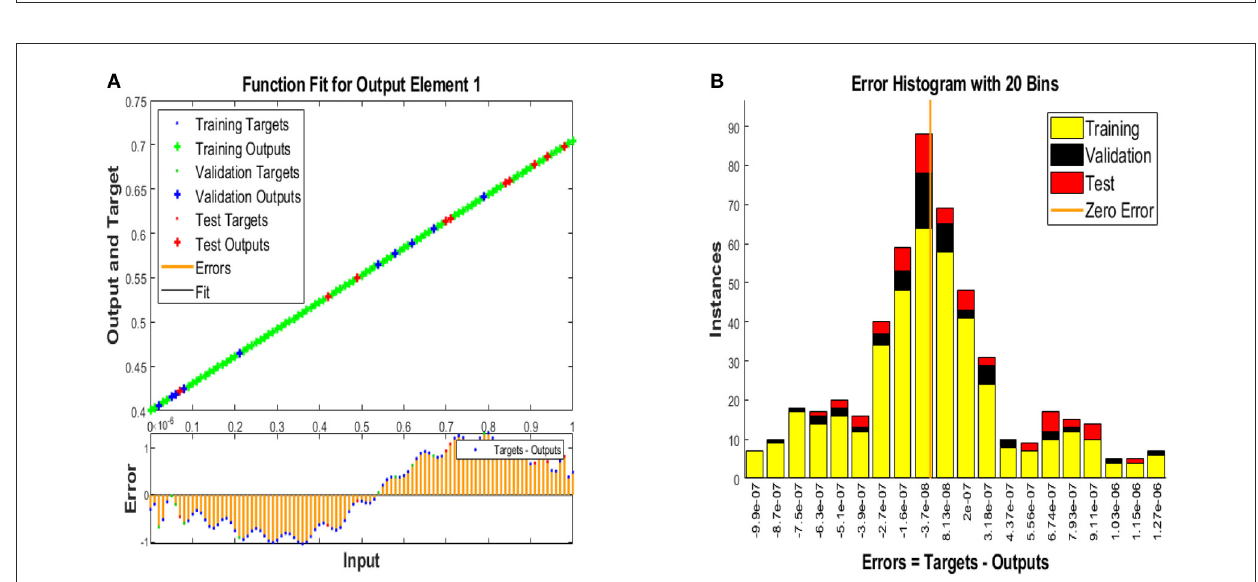
FIGURE6 Results and EHs performances for the HBV system. (A) Results: Case 2. (B) EHs: Case 2.